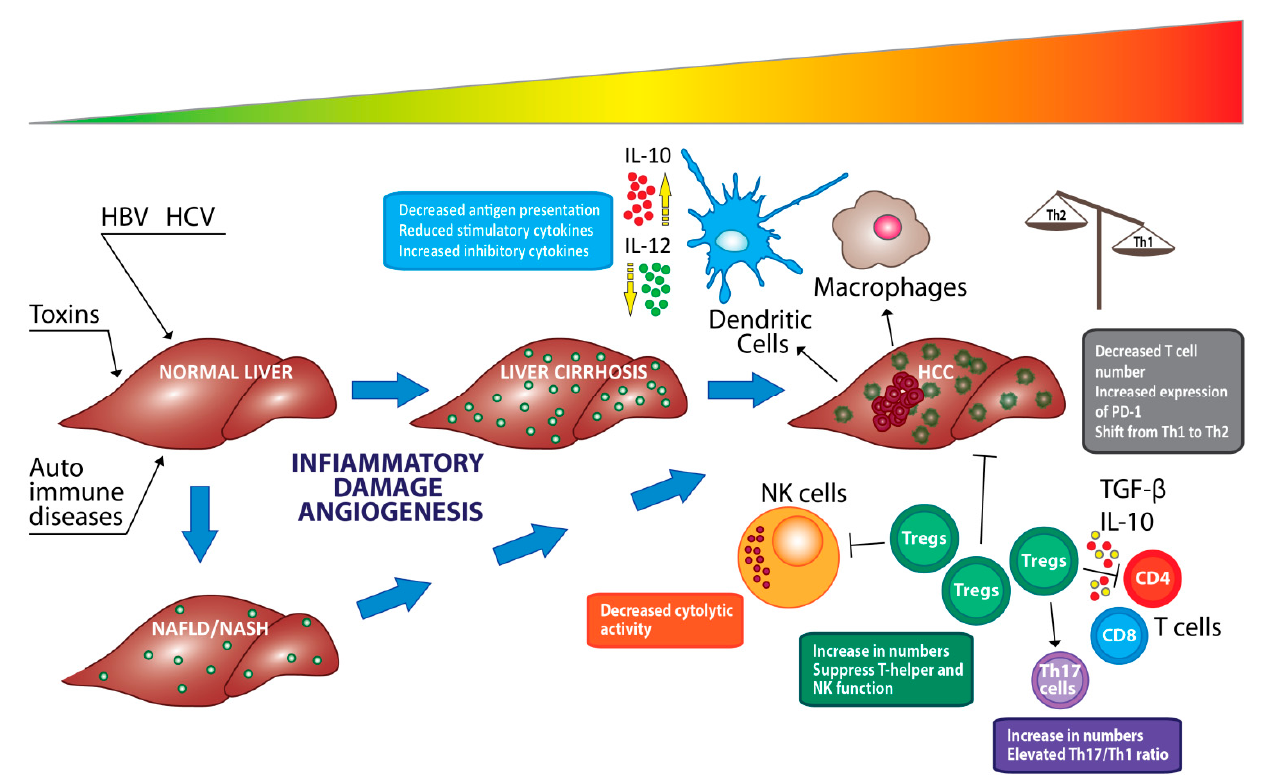
Figure 3. Immune system involvement in the pathogenesis of HCC. Involvement and cross talk between immune cells in the creation of an immunosuppressive environment that allows the tumor to evade immunosurveillance through multiple mechanisms. These mechanisms allow the accumulation of immunosuppressive cell populations resulting in the remodeling of the TME through pathogenic immune factors that induced immuno-imbalance and the development of HCC.